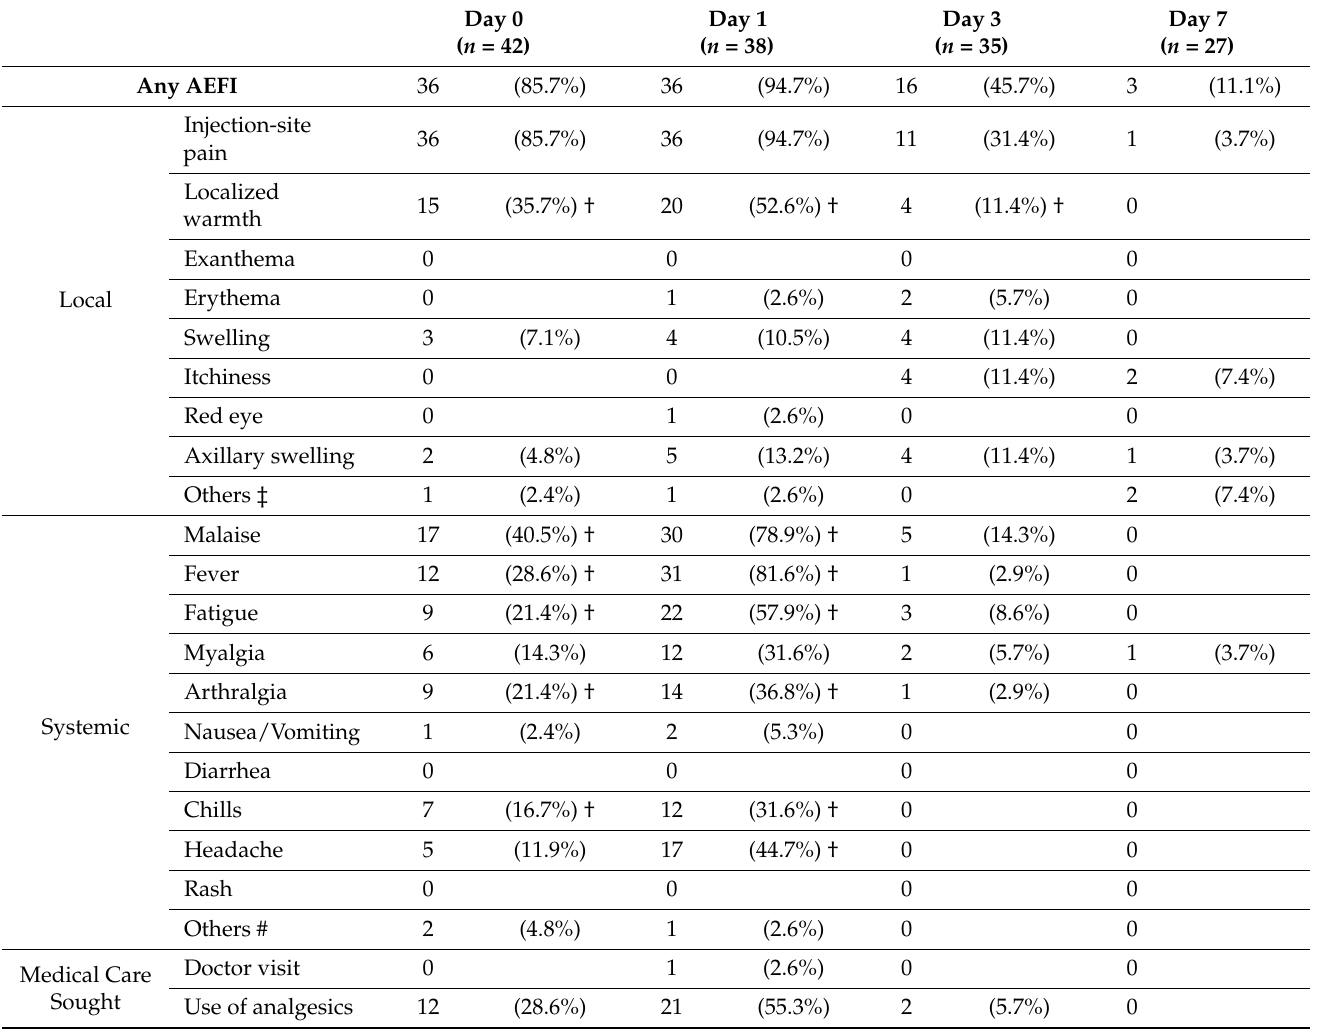
Table 4. Adverse events following immunization (AEFIs) for the third dose. AEFIs: adverse events following immunization. † Fisher’s exact test, significantly higher ( p < 0.05) than the first dose (Table 2). ‡ Other local AEFIs include sore neck, sore throat, and others. # Other systemic AEFIs include anorexia, hot flashes, mild chest pain, and others. Day 0 is defined as the day of